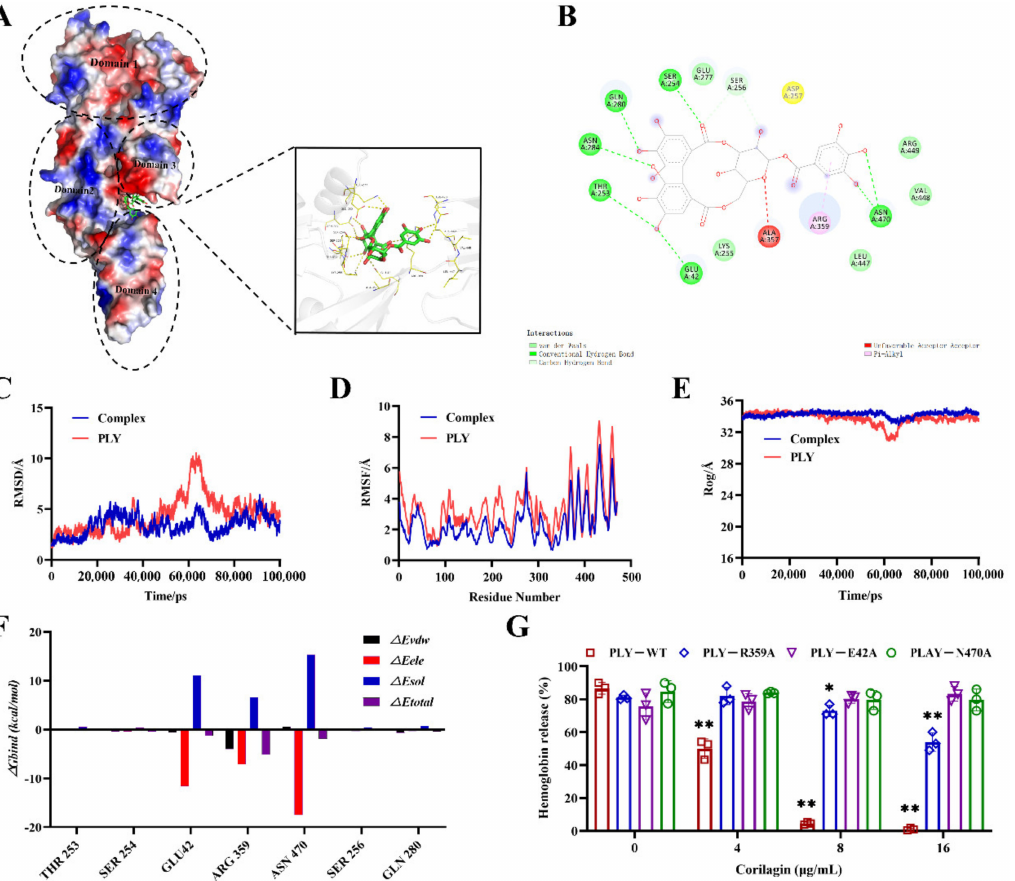
Figure 5. Prediction of binding modes of corilagin to PLY protein using molecular modeling. ( A ) The binding mode of corilagin to PLY on the basis of MD simulation. During the standard MD simulation process, corilagin could strongly embed at the groove between Domain 3 and Domain 4 of PLY. ( B ) Asn 470, Glu 42, Thr 253 and Arg359 residues were the key sites for corilagin binding with PLY. ( C ) RMSD fluctuation of the complex (corilagin − PLY) and PLY throughout the MD simulation was found. ( D ) RMSF curves of the complex and PLY were obtained. ( E ) The Rog curves of the complex and PLY were obtained. ( F ) The binding energies of the complex and PLY were calculated according to an MM − PBSA analysis. ( G ) Mutation of binding sites disrupted the inhibitory effect of corilagin on PLY. * p < 0.05, ** p <